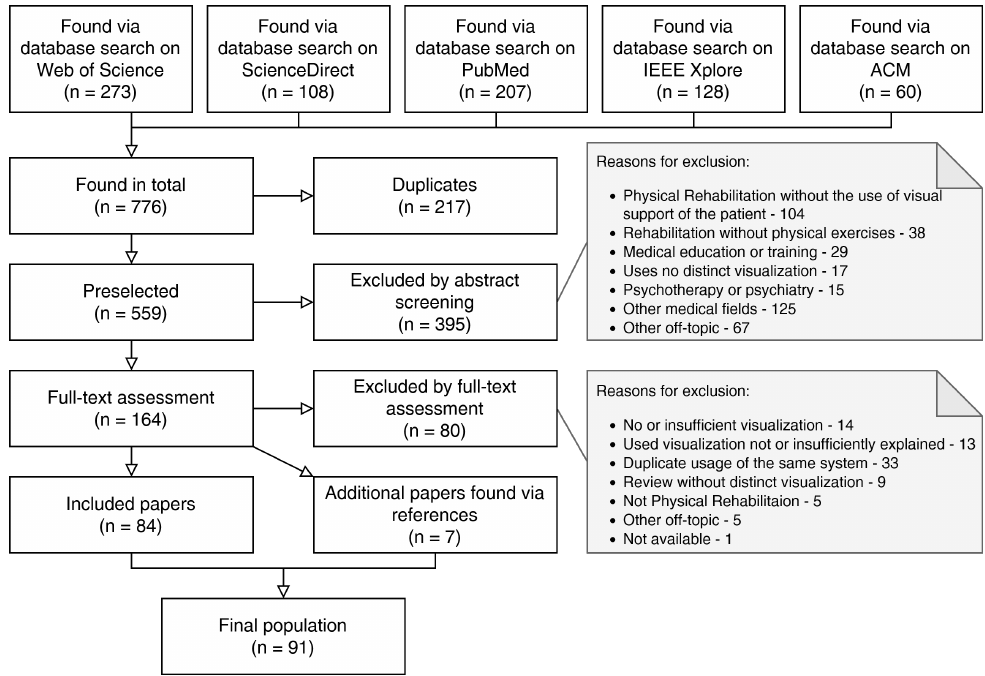
Figure 1. Flow chart of the study selection process, own representation based on